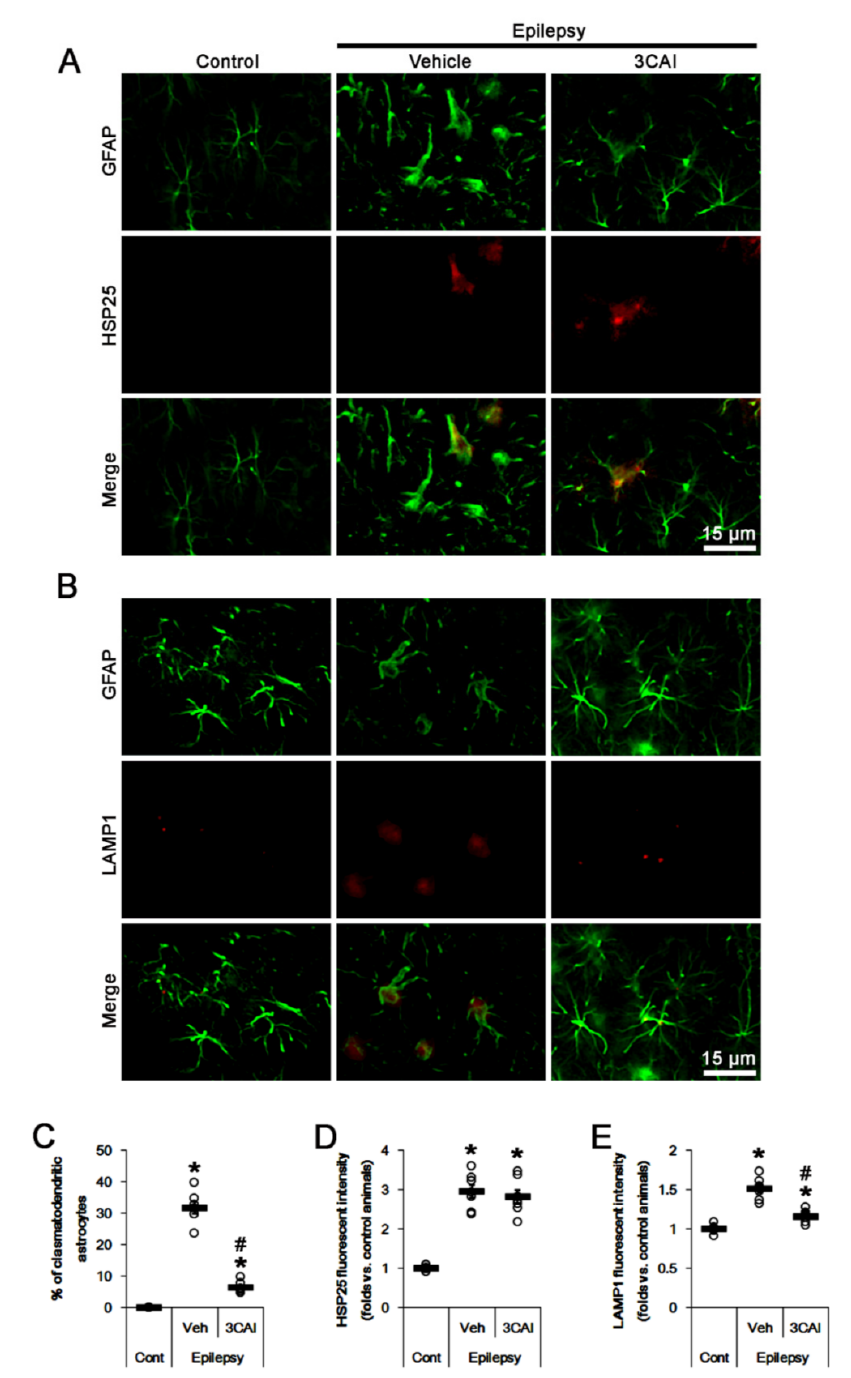
Figure 7. Effects of 3CAI on heat shock protein 25 (HSP25) and lysosomal-associated membrane protein 1 (LAMP1) expressions in CA1 astrocytes of control and epileptic rats. As compared to control animals (Cont), HSP25 and LAMP1 expressions are upregulated in CA1 astrocytes in epileptic rats. 3CAI reduces the increased LAMP1, but not HSP25, expression in CA1 astrocytes, as compared to vehicle (Veh). ( A , B ) Representative photos demonstrating astroglial HSP25 ( A ) and LAMP1 ( B ) expressions in CA1 astrocytes. ( C – E ) Quantifications of the fraction of clasmatodendritic astrocytes in total CA1 astrocytes ( C ), HSP25 expression ( D ) and LAMP1 fluorescent intensity ( E ) in CA1 astrocytes. Open circles indicate each value. Horizontal bars indicate the mean value. Error bars indicate SEM (*, # p < 0.05 vs. control and vehicle-treated epileptic rats, respectively; n = 7,